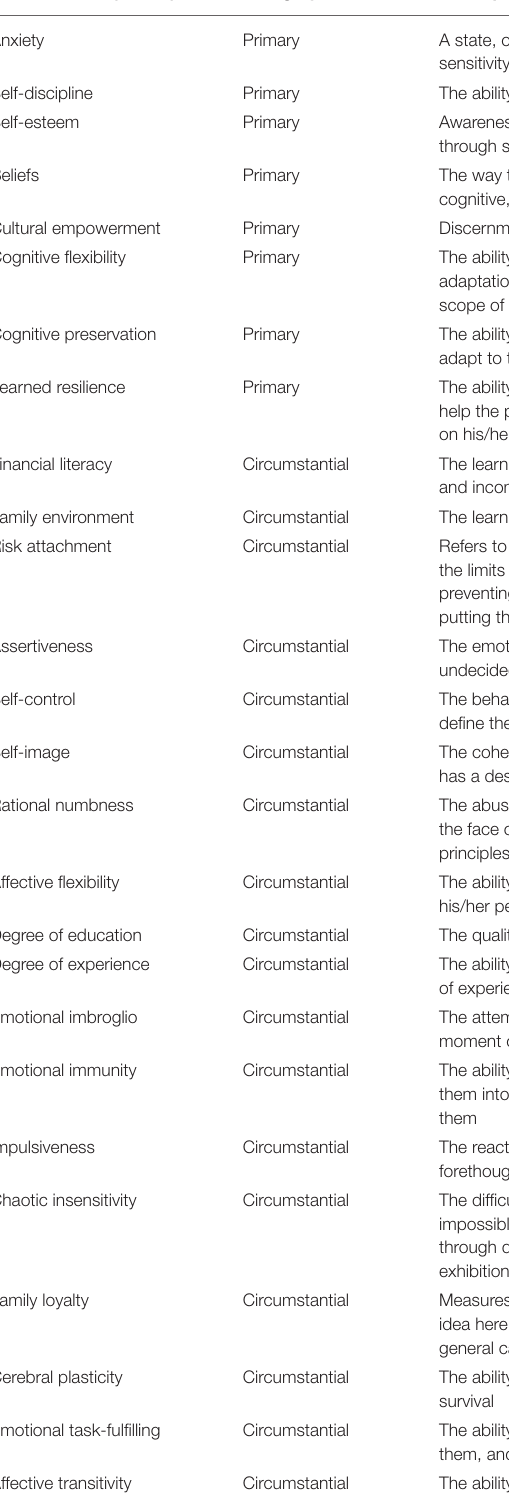
TABLE 1 | Description of metrics associated with affective, cognitive, and behavioral manifestations. Characteristic (metric) Category Description Anxiety